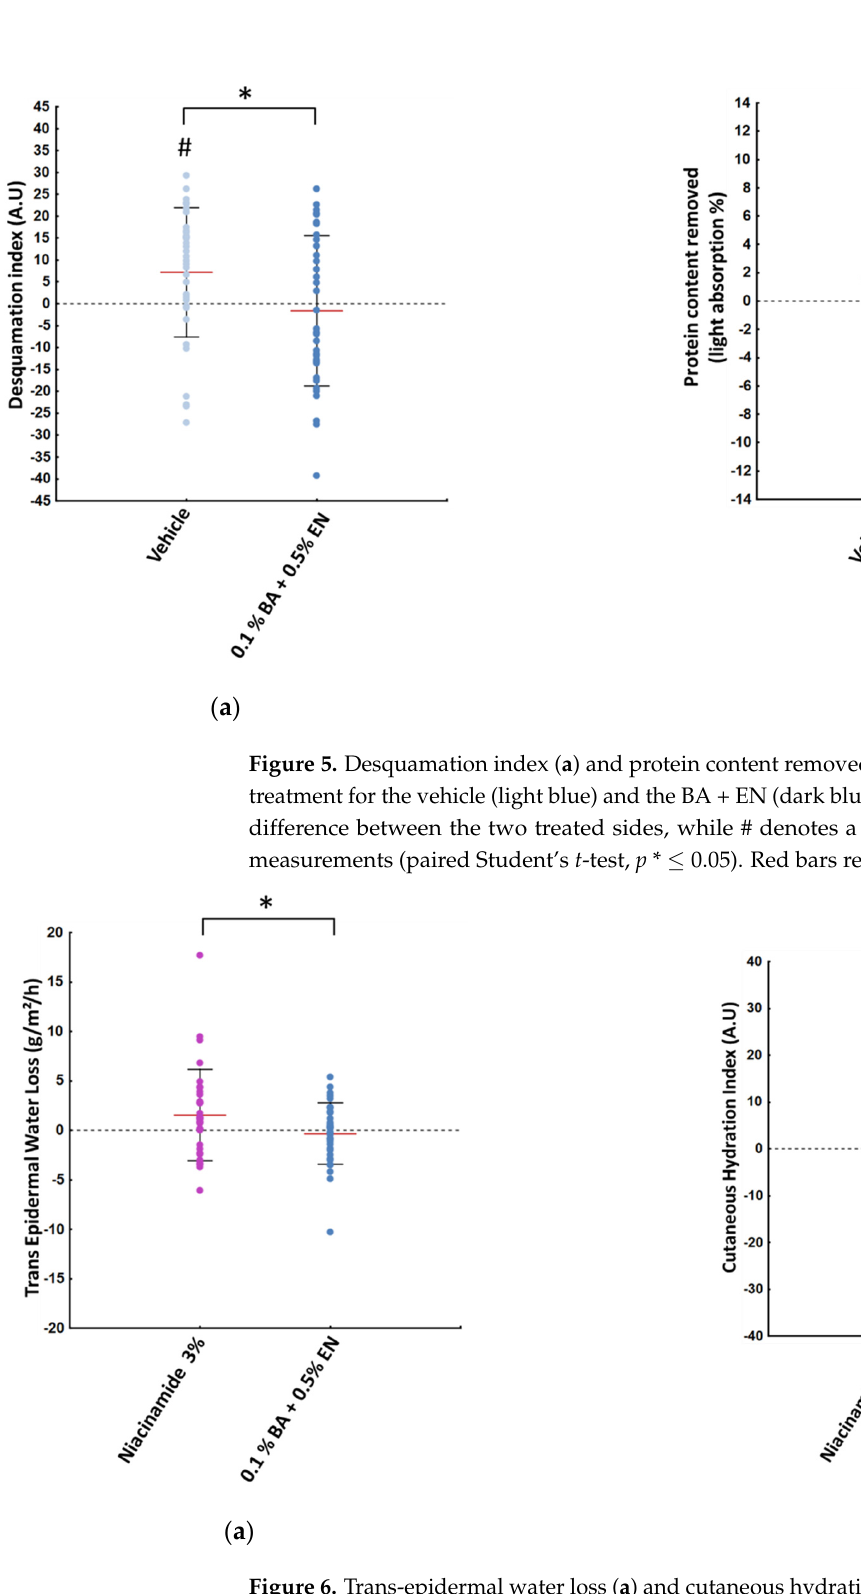
Figure 7. Schematic illustration of the multidirectional effects of BA and EN extracts on the skin. 3. Discussion Niacinamide has long been considered as one of the “gold standard” ingredients in skin care due to its ability to ameliorate wrinkles, pigmentation, blemishes, and skin bar- rier. In this study, we explored the Scandinavian flora, for an alternative to niacinamide, to strengthen the skin barrier. Swedish plant extracts were compared for skin barrier ben- efits and two candidates outperformed the rest: Betula alba (BA) and Empetrum nigrum (EN). These two extracts upregulated genes as well as proteins important for skin barrier